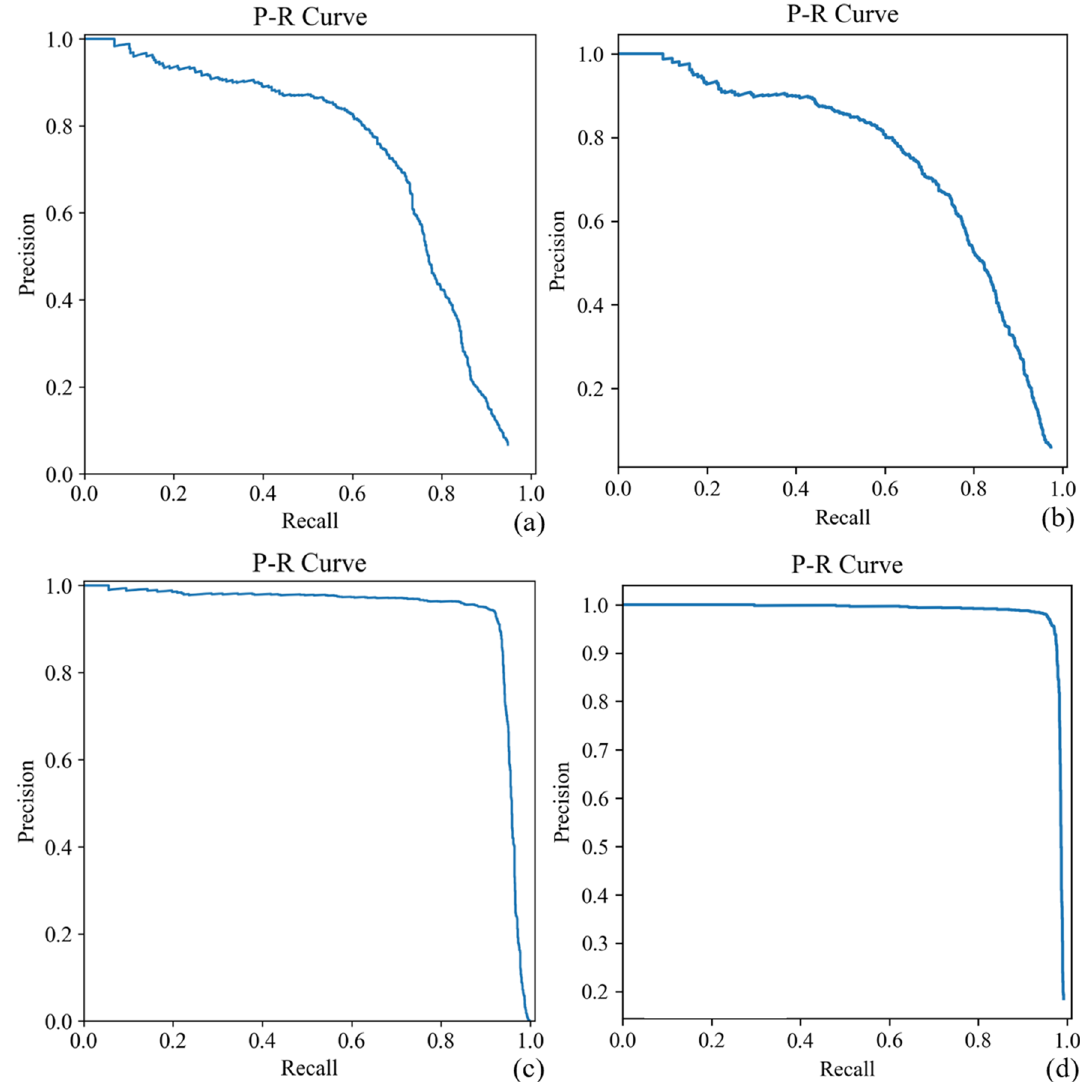
Figure 1. P-R curves for different models; (a) model A, (b) model B, (c) model C, and (d) model D. The AUC for models A, B, C and D were 0.718, 0.744, 0.935, and 0.982,